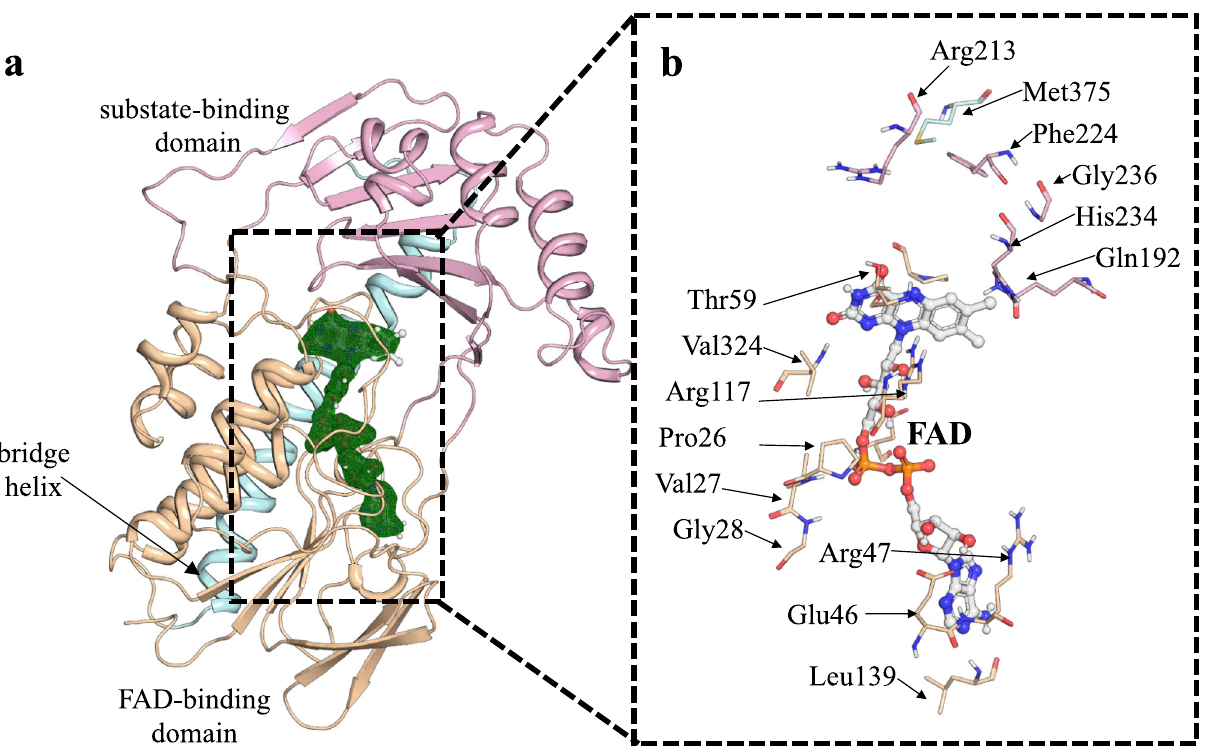
Fig. 1 Tet(X6) has a conserved architecture of type 1 TDases. a Structure of anhydrotetracycline free Tet(X6) determined here (8ER1). The substrate- binding domain is colored pink. The FAD-binding domain is colored orange. The C-terminal bridge helix is colored blue. Omit map for the bound FAD omitted from the Tet(X6) anhydrotetracycline free structure determined here (8ER1) is shown in green and density is contoured at 2.5 σ . The FAD is bound in an “ IN ” orientation consistent with previously solved type 1 TDase structures. b Key residues in the Tet(X6) anhydrotetracycline free structure determined here (8ER1) that interact with FAD are shown. Residues in the substrate binding pocket are also highlighted. Color scheme: orange – residues from the FAD binding domain; pink – residues from the substrate binding domain; and blue – residues from the C-terminal bridge